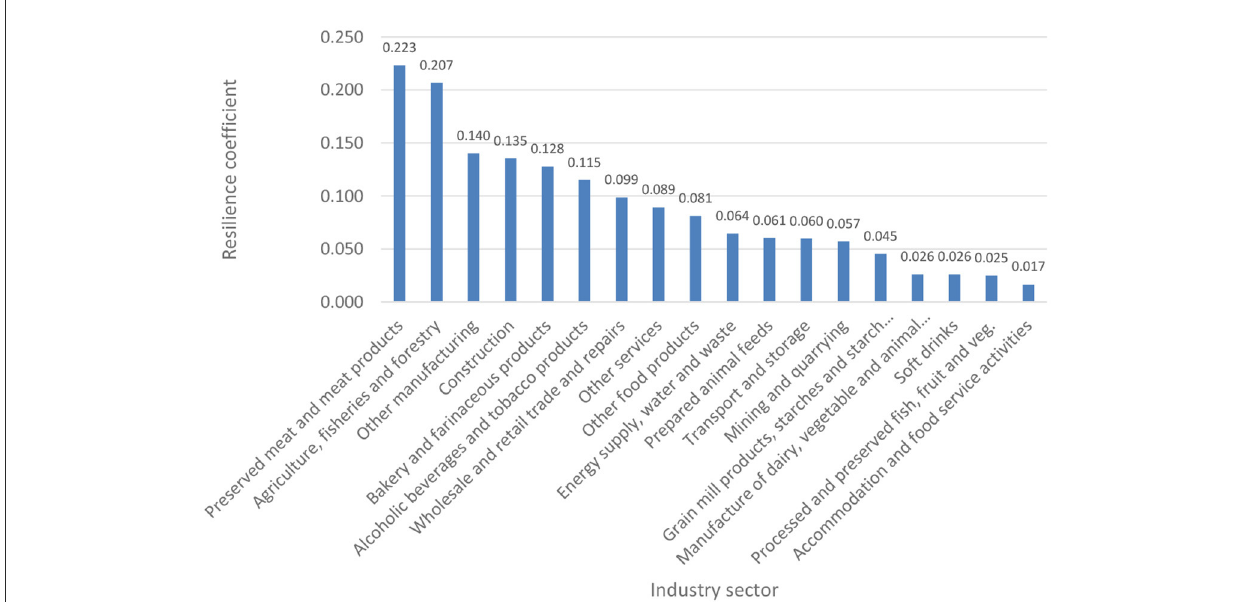
FIGURE5 Estimated resilience coefficient by sector following a contraction of the accommodation and food service sector. Source: Own computation based on the Scottish input–output tables from 1998 to 2019.